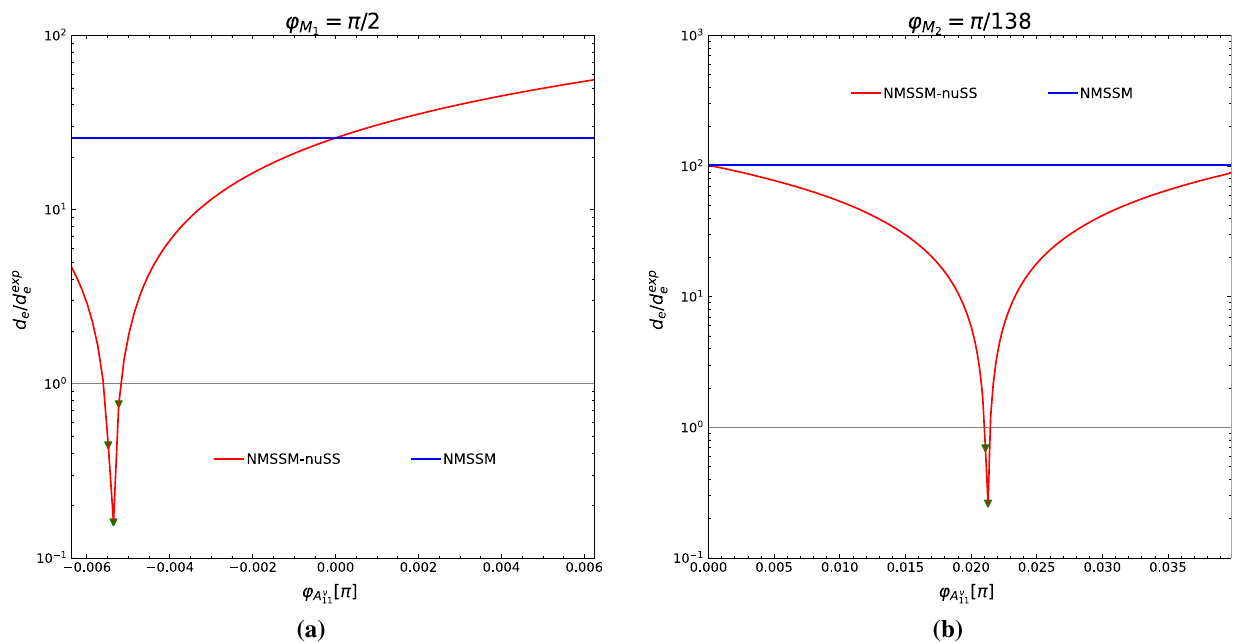
Fig. 7 The EDM of the electron in the NMSSM with (red) and without (blue) inverse seesaw mechanism as a function of the complex phase of = π/ 2, b ϕ = π/ 138 A ν where a ϕ M M 2 11 1 not only the neutralino contribution but also the chargino